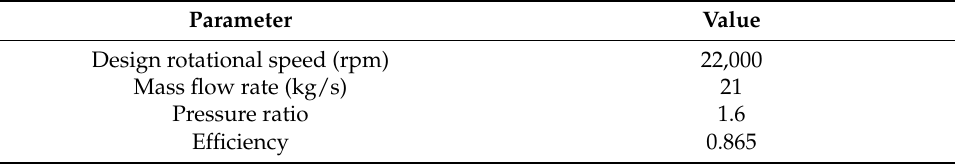
Table 1. 11D axial compressor